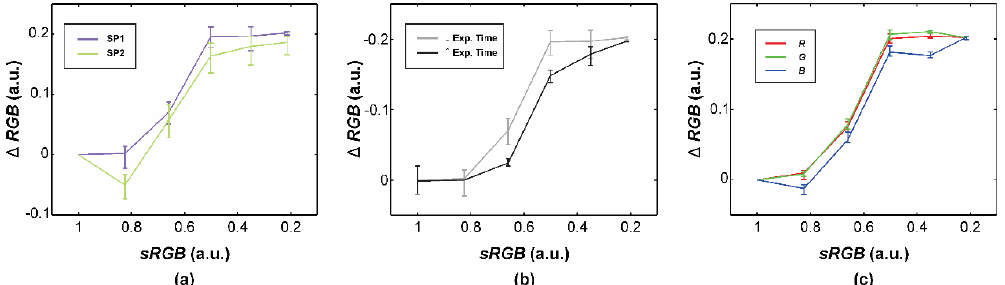
Figure 7. Absolute differences ( ΔRGB ) between the acquired and normalized referential RGB values ( sRGB ) comparing ( a ) both smartphones (SP1, SP2), ( b ) shorter (full-range CCT’s patch 19) and longer (patch 20) exposure times, and ( c ) separate SP1′s RGB channels. Units a.u. are retrieved from the normalization against the white standard (i.e., patches 19 or 20).